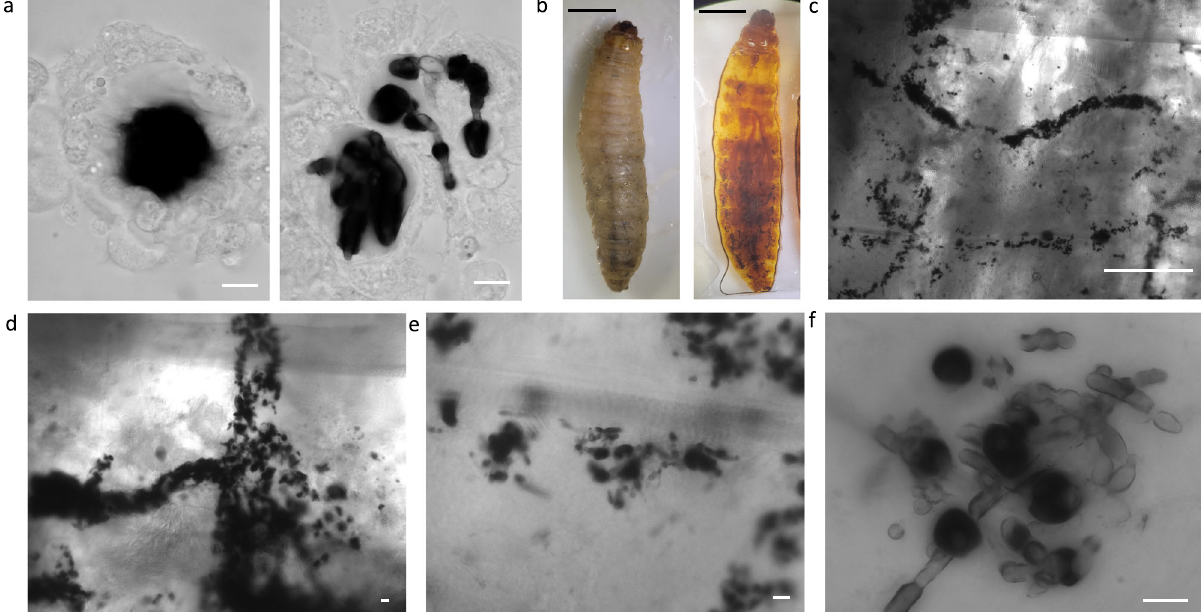
Fig. 4 Visualizing the melanization response to infection with Candida albicans . a Similar to the hemolymph from larvae infected with C. neoformans, we are able to see melanized nodules within the hemolymph. The melanized spot within these nodules appears more diffuse/less de fi ned, and in some, the presence of less-melanized hyphae is distinct (red arrows). b We can also use tissue clearing to visualize the melanized nodules during C. albicans infection. c , d The melanized C. albicans seem to cluster in speci fi c areas, in long strips within the larvae (yellow arrows). e , f Under higher magni fi cation, we can see hyphal structures of C. albicans, which corresponds to what is previously known about C. albicans morphology in G. mellonella. Interestingly, the hyphae appear less melanized (red arrows) compared to the spherical yeast (white arrows) ( f ). All panels show representative images from 3 biological replicates. Scale bars in a , d – f represent 10 µ m, in c represent 500 µ m, and in b represent 50